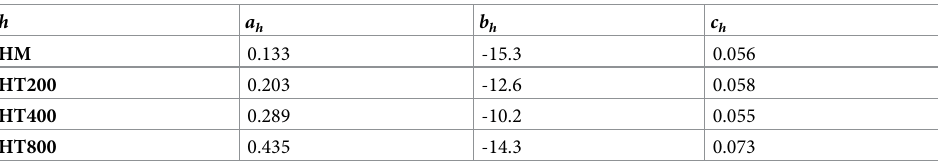
Table 1. Fitting parameters for all simulation cases with different surface